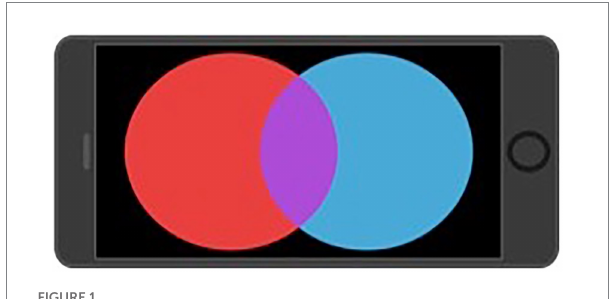
FIGURE 1 A Venn diagram using red and blue circles overlapping in a purple section, rendered here as it might be visually presented using the